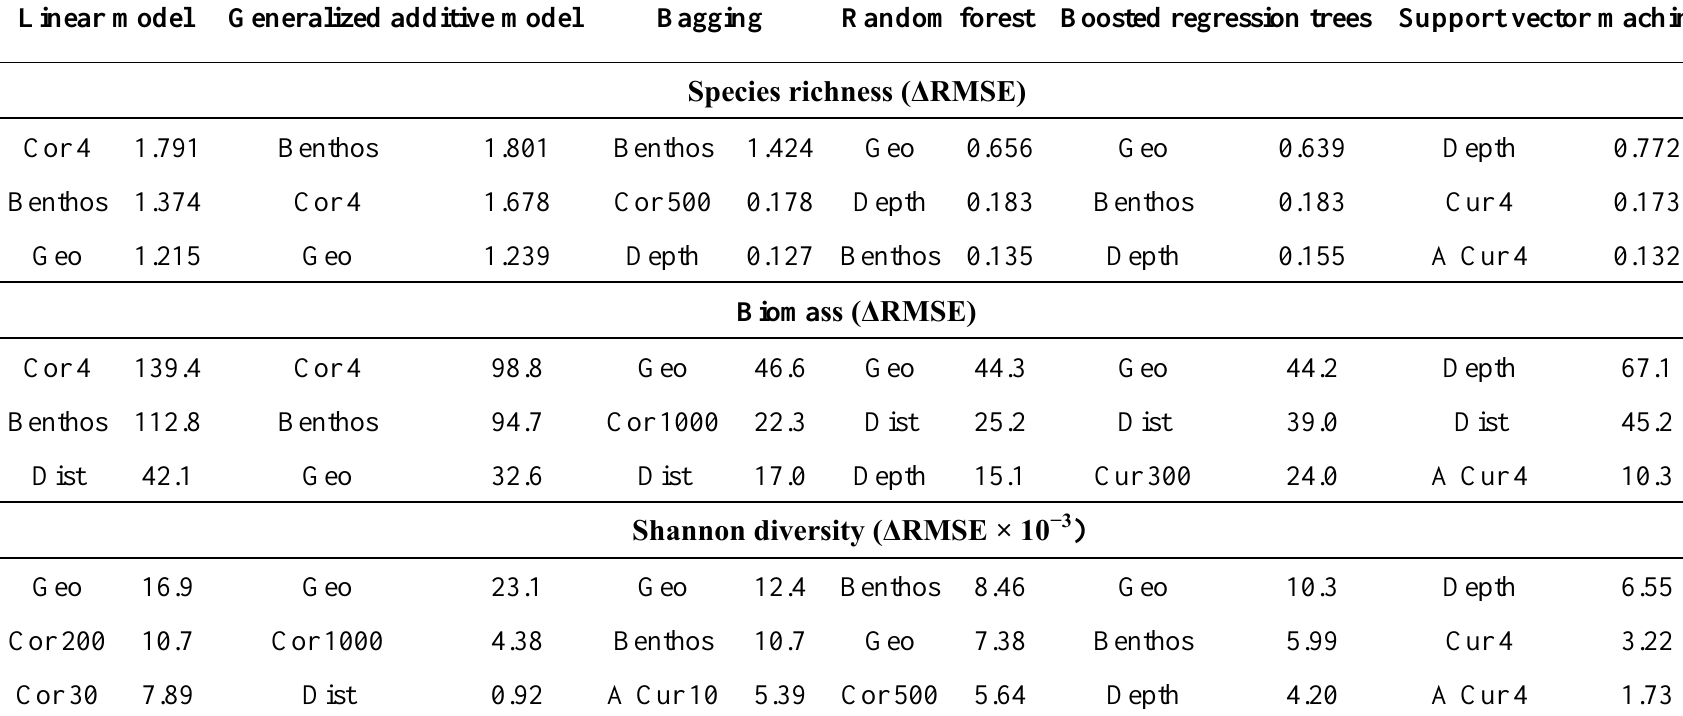
Table 4. The three most important predictors for each response variable and their importance value, listed in order of importance and by model type. Cor = Coral, Geo = Geomorphology, Dist = Distance from land, Cur = curvature, A Cur = Absolute curvature. Numbers following predictor name indicate radius of